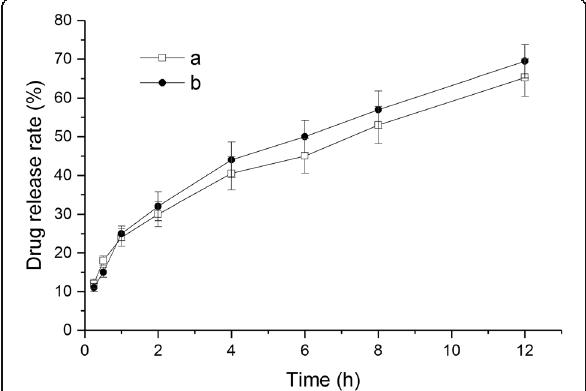
Fig. 11 In vitro dissolution profiles of GA from GA-loaded liposomes in a PBS and b physiological saline solution (mean ± SD, n = 3)